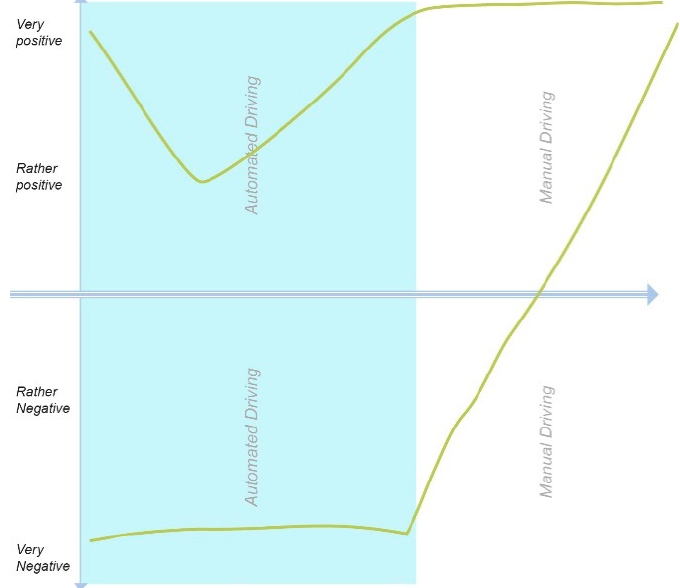
Figure 1. Curves with upward inclination.